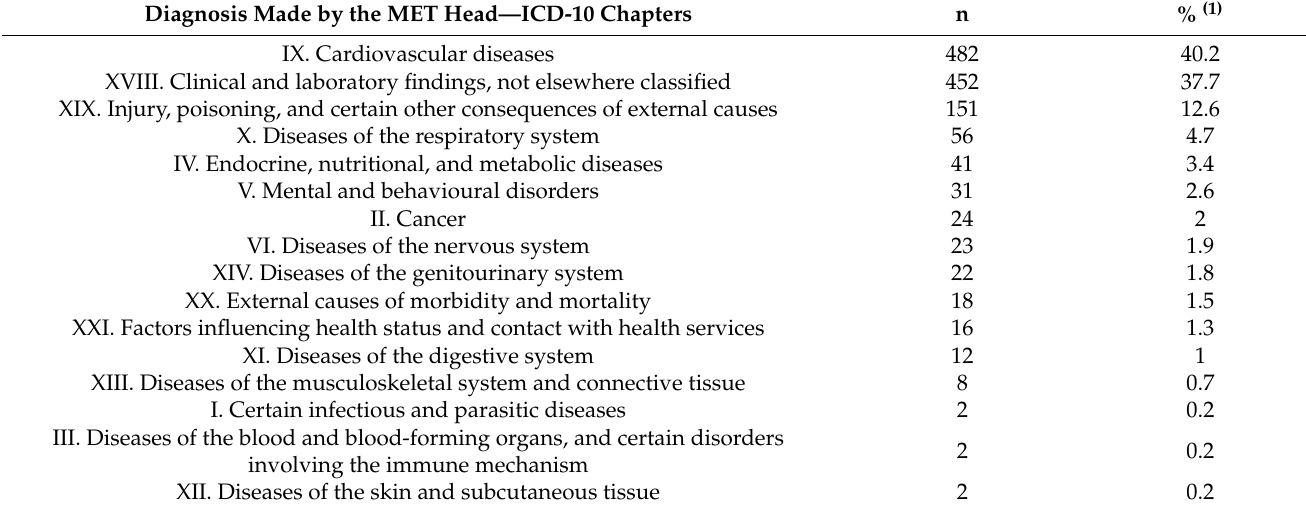
Table 2. MET head diagnosis by ICD-10 classification.